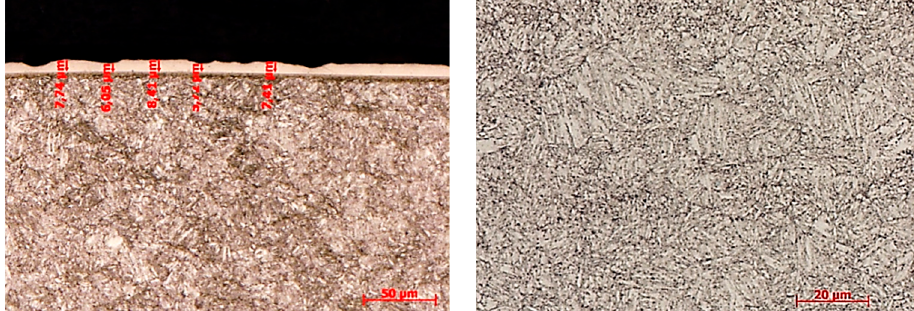
Figure 11. Sample electroless nickel-plated, turned with a feed of f 1 = 0.08 mm—surface with marked layer thickness—magnified 200 × ( left ); sample center—magnified 500 × ( right ).